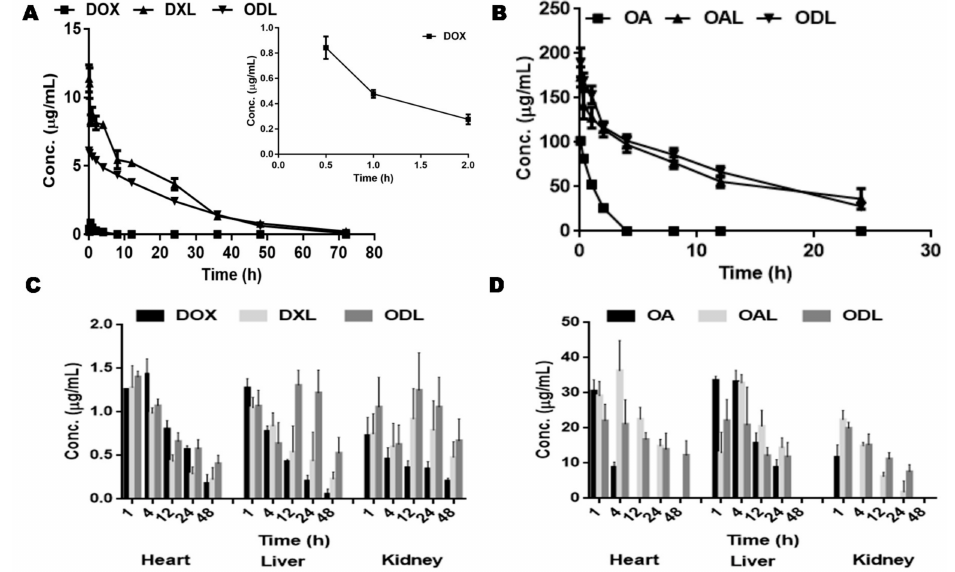
Figure 8. Bio-distribution study of Kunming mice ( n = 3) after single bolus i.v. injection through tail vein of drug solutions (DOX = 5 mg/Kg and OA = 25 mg/Kg) and liposomes [DOX loaded (DXL = 7 mg/Kg), OA loaded (OAL = 35 mg/Kg), OA and DOX loaded combined, ODL {OA:DOX; 5:1 (OA = 20 mg/Kg, DOX = 4 mg/Kg)}]; ( A ) Plasma vs time profile of DOX delivered through solution or liposomes ( B ) Plasma vs time profile of OA delivered through solution or liposomes ( C ) DOX distribution in vital organs ( D ) OA distribution in vital